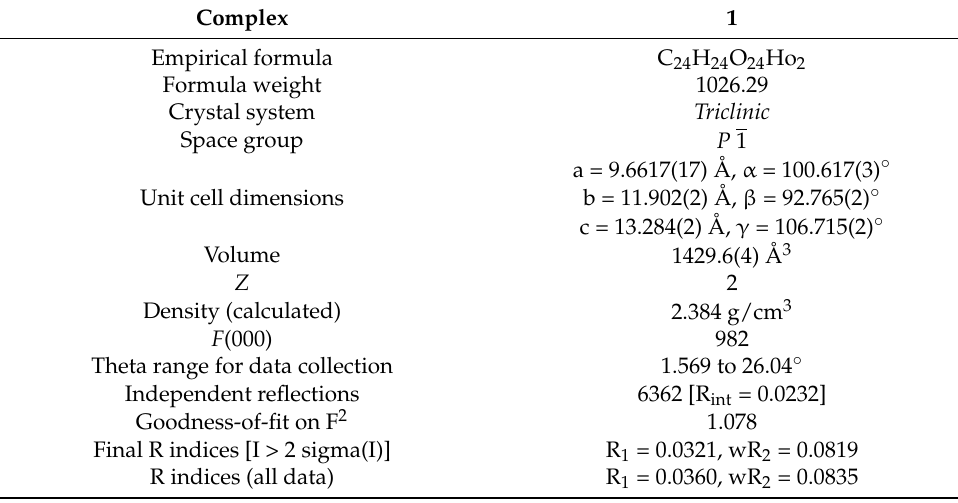
Table 1. Crystal Data and Structure Refinement for complex 1